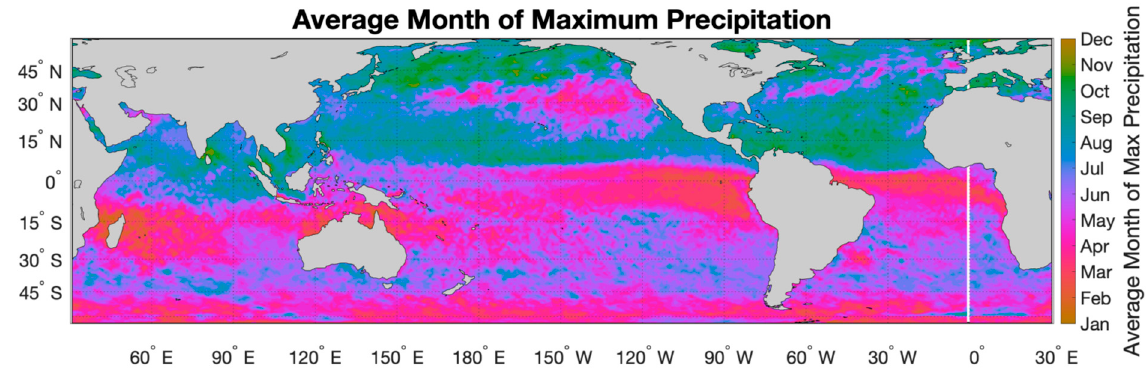
Figure 10. Month of maximum precipitation from IMERG data. Monthly averaged values from June 2000 to May 2019 were used. For each year, the month with the maximum average precipitation value was recorded at each point in space, and then the mean of those 19 values was used as the average maximum month. Color scale is on the right.